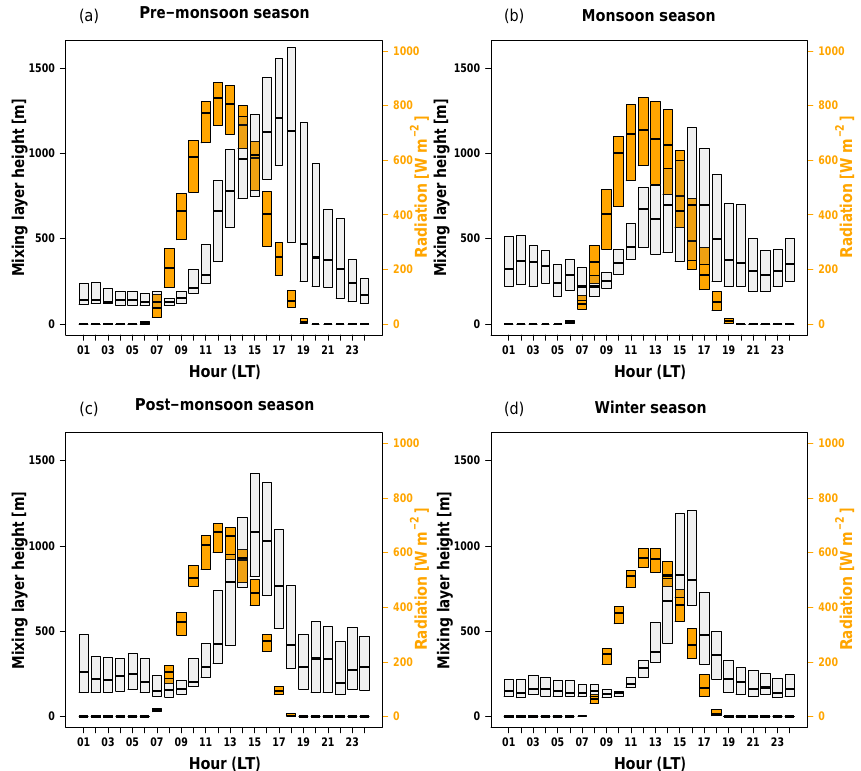
Figure 4. Diurnal cycle of the MLH (grey) and solar radiation at the surface (orange) as a boxplot (showing the median, the upper and lower quantile) for (a) the pre-monsoon (March–May 2013), (b) the monsoon (June–September 2013), (c) the post-monsoon